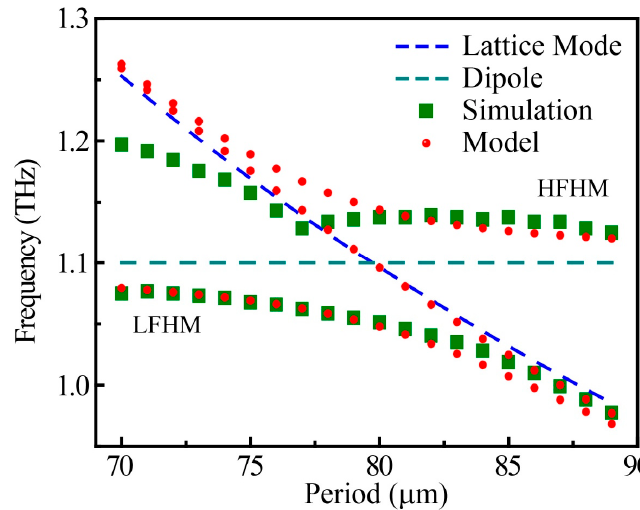
Figure 8. Analytical model of a lattice-induced anti-crossing. Resonance frequency of the split modes (LFHM and HFHM) of Figure 4 alongside the lattice mode frequency (blue dashed line) as a function of the lattice period according to the simulations of Figure 4 (green squares) and the fitted analytical eigensolution of the three-oscillator model (red circles). An anti-crossing is seen at the intersection of the dipole mode of 1.1 THz (cyan dashed line) and the calculated lattice mode. Adapted with permission from ref [36], AIP Publishing.